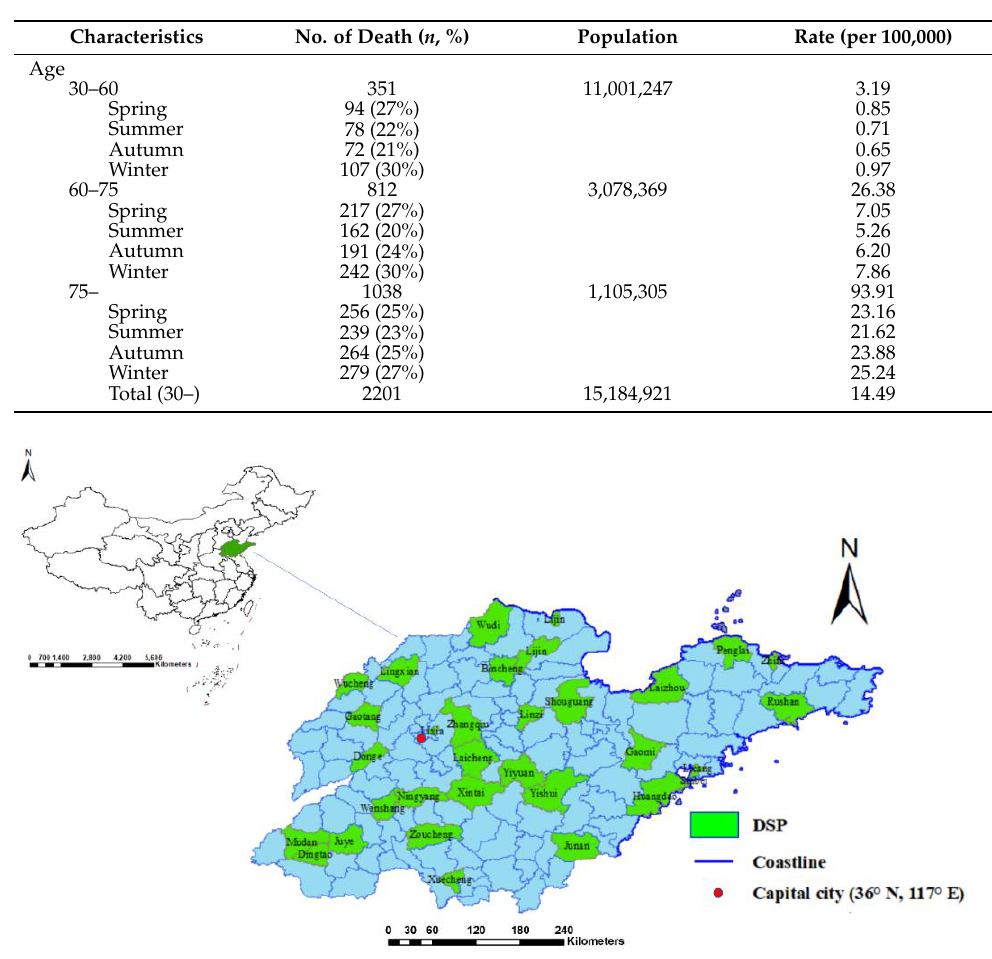
Figure 1. Surveillance points in Shandong Province, China, 2014.